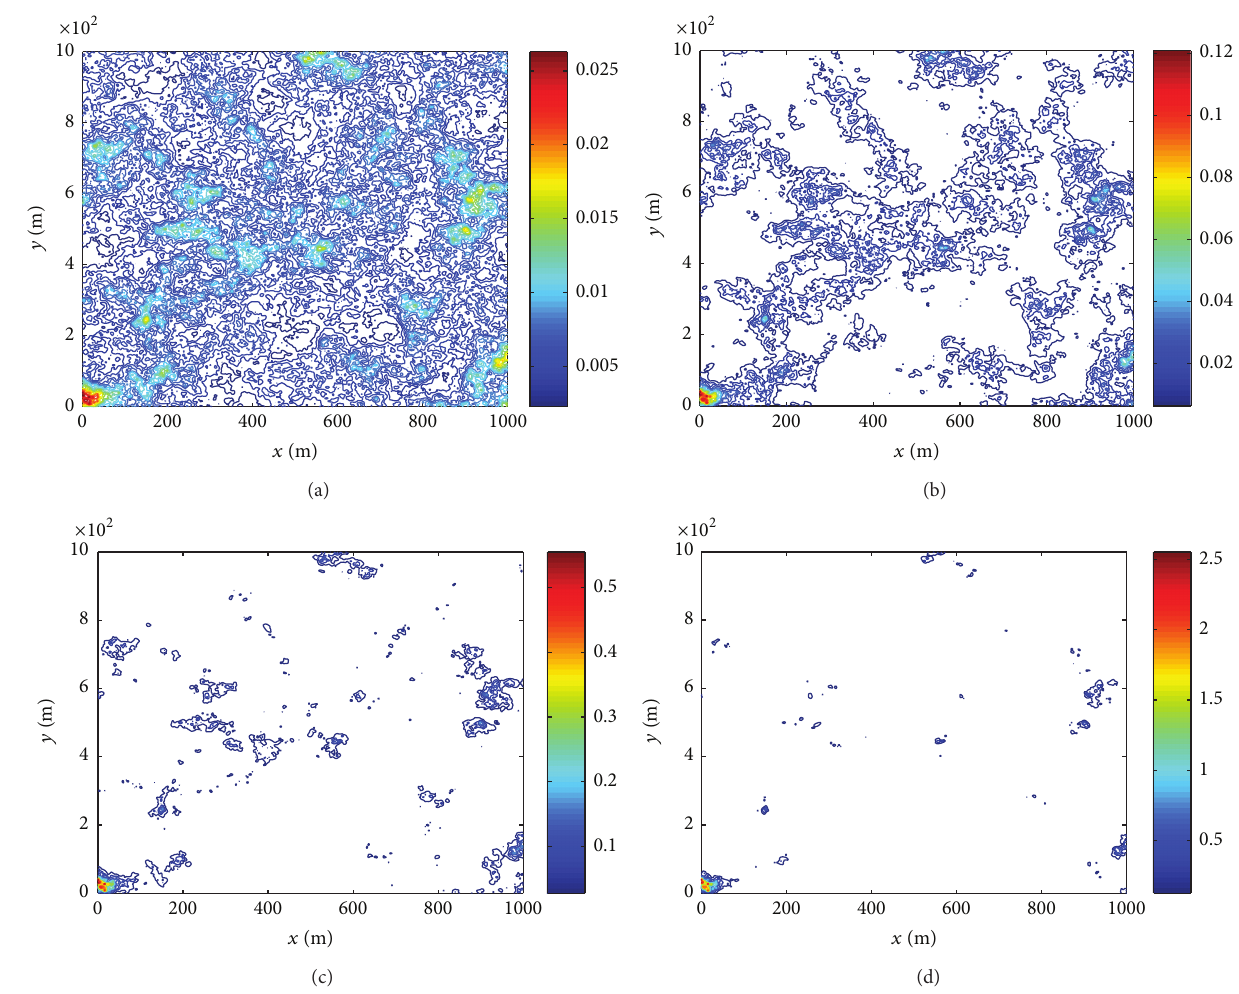
Figure 4: A realization of the random saturated conductivity fields of different standard deviations under 𝜆 𝑥 = 𝜆 𝑦 = 100 m: (a) 𝜎 ln 𝐾 = 0.5 , (b) 𝜎 ln 𝐾 = 1.0 , (c) 𝜎 ln 𝐾 = 1.5 , and (d) 𝜎 ln 𝐾 = 2.0